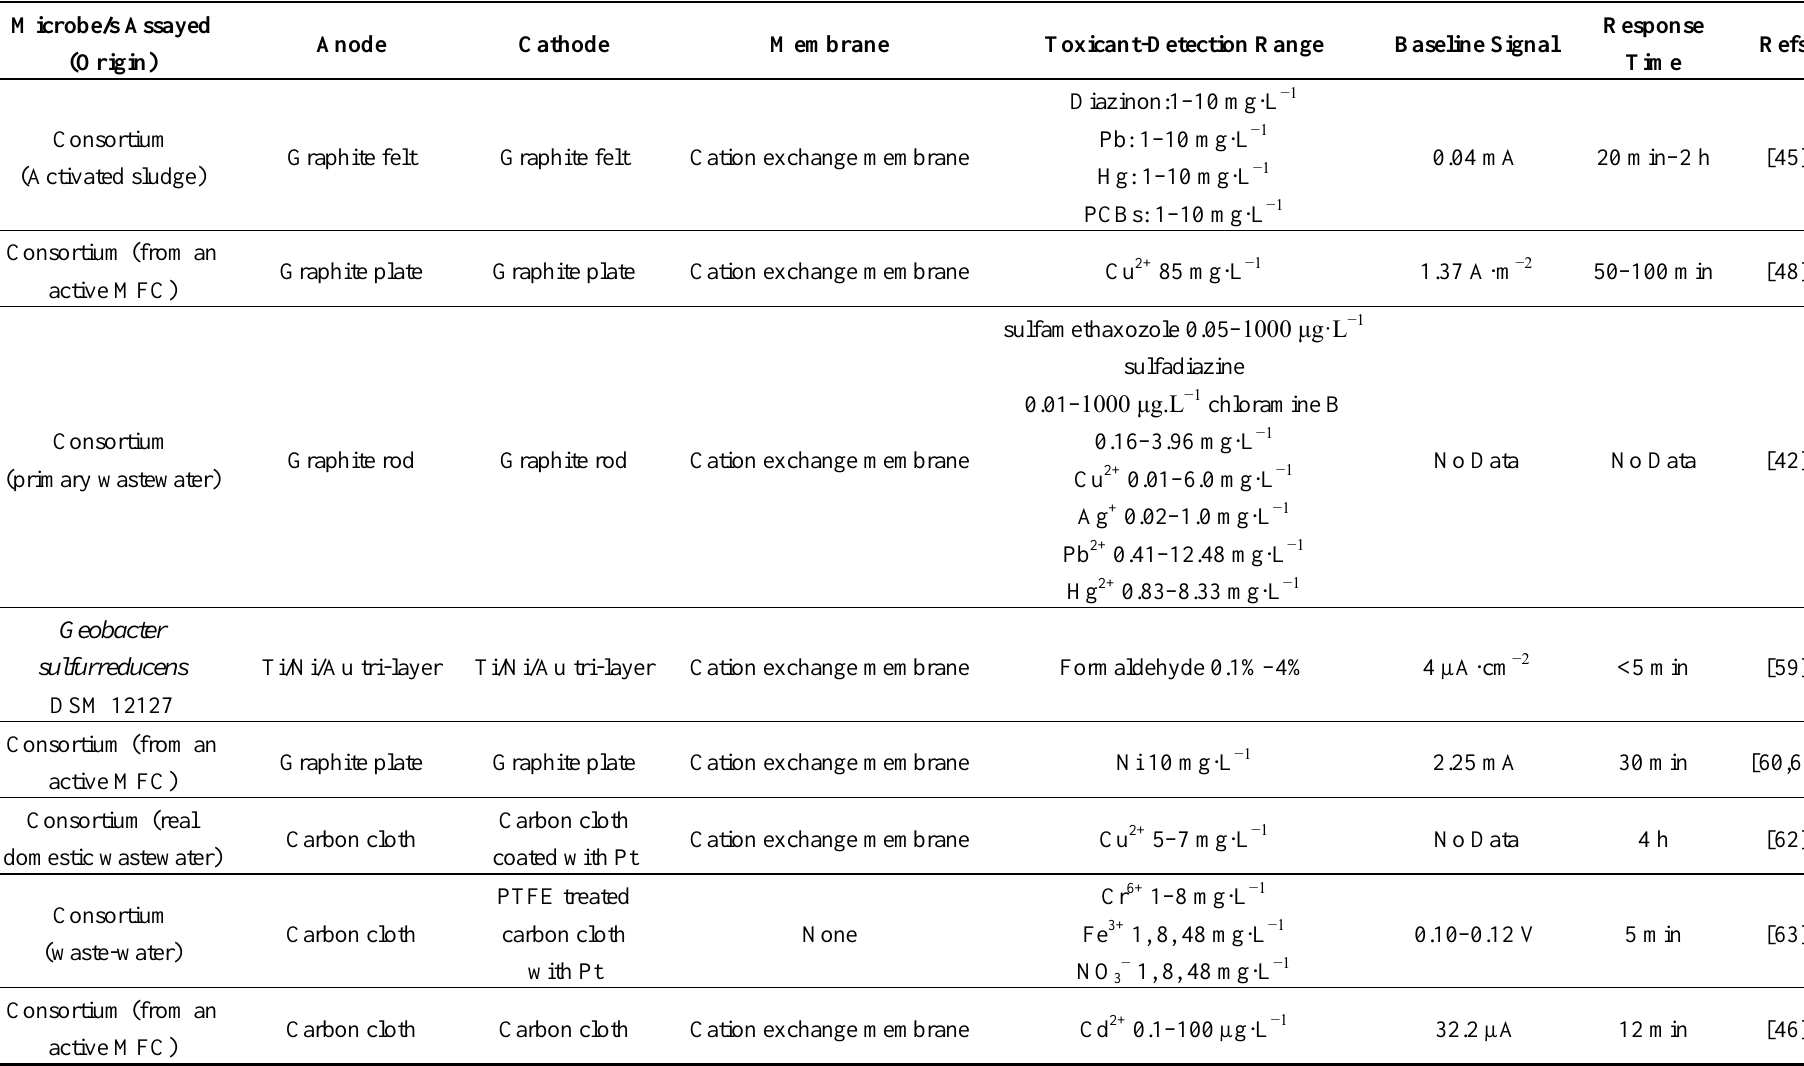
Table 3. Summary of the analytical performance, construction, and functional characteristics of MFCs used as toxicant